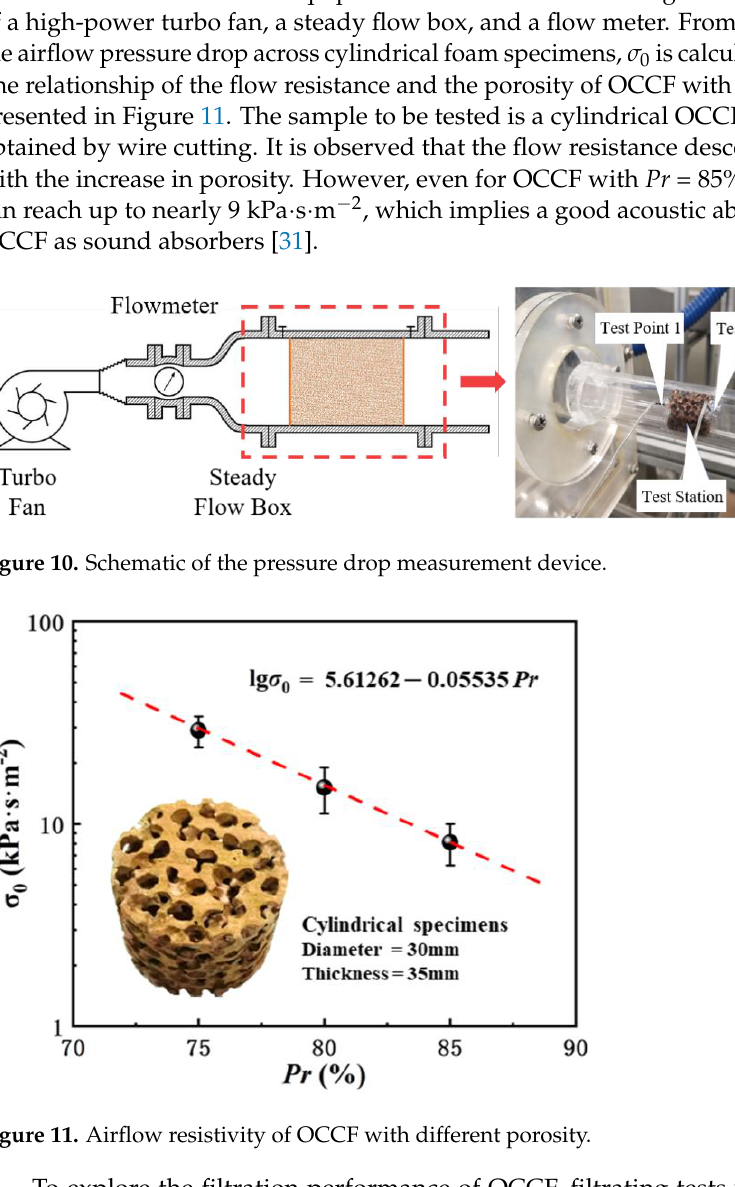
Figure 9. ( a ) FE models and ( b ) deformation configurations at compressive strain of 0.35.